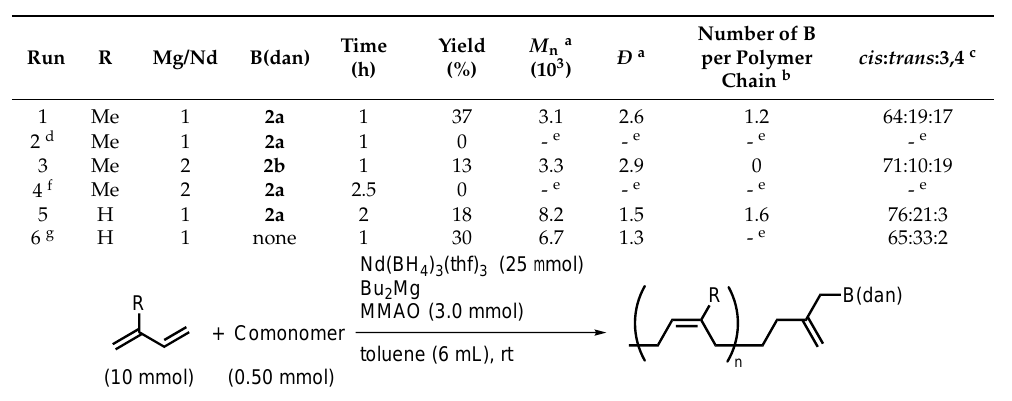
a Determined by GPC calibrated with polystyrene standards. b Determined by the boron content and molecular weight of the polymer. c Determined by NMR. d Homopolymerization of 2a . e Not deter- mined. f The polymerization was conducted in the absence of MMAO and at 45 °C. g 0.15 mmol of i C 3 H 7 B(dan) was